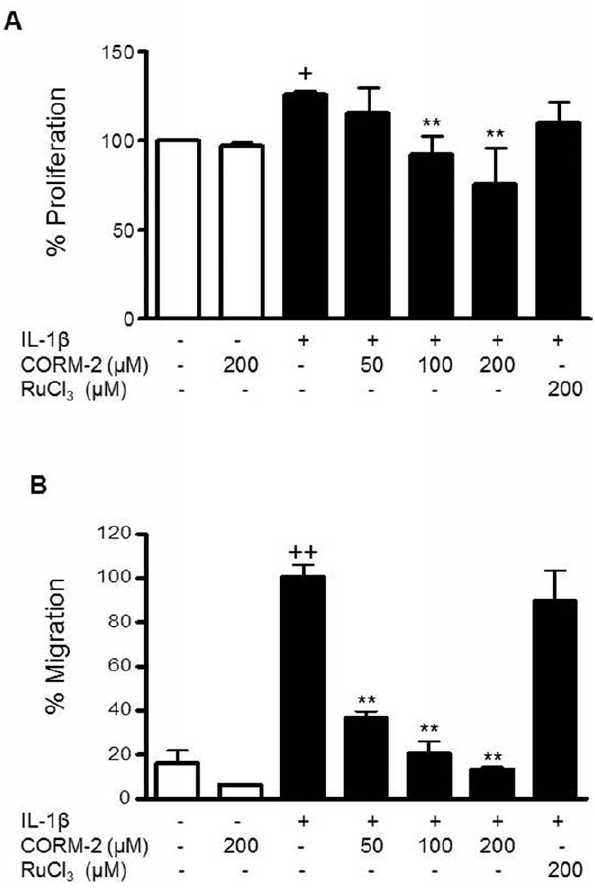
Figure 2. Effect of CORM-2 on synoviocyte proliferation and migration rate. Cells were stimulated with IL-1 b (10 ng/ml) for 24 h in the presence or absence of CORM-2 (50, 100, 200 m M) or RuCl 3 (200 m M). (A) Cell proliferation was determined by the MTT assay. (B) Transwell chambers were kept in culture for 24 h. Upper compartment was detached and cells migrated to the lower side were counted in 6–8 microscopic power fields. Data (A) are expressed as mean 6 S.E.M. of % proliferating cells, considering 100% the proliferation induced in basal conditions whereas data (B) are expressed as % of cells migrated to the lower compartment, considering 100% the migration induced by IL-1 b . Duplicate samples from 6 (A) and 4 (B) patients were used. + P , 0.05, ++ P , 0.01 with respect to nonstimulated cells. ** P , 0.01 with respect to IL-1 b .